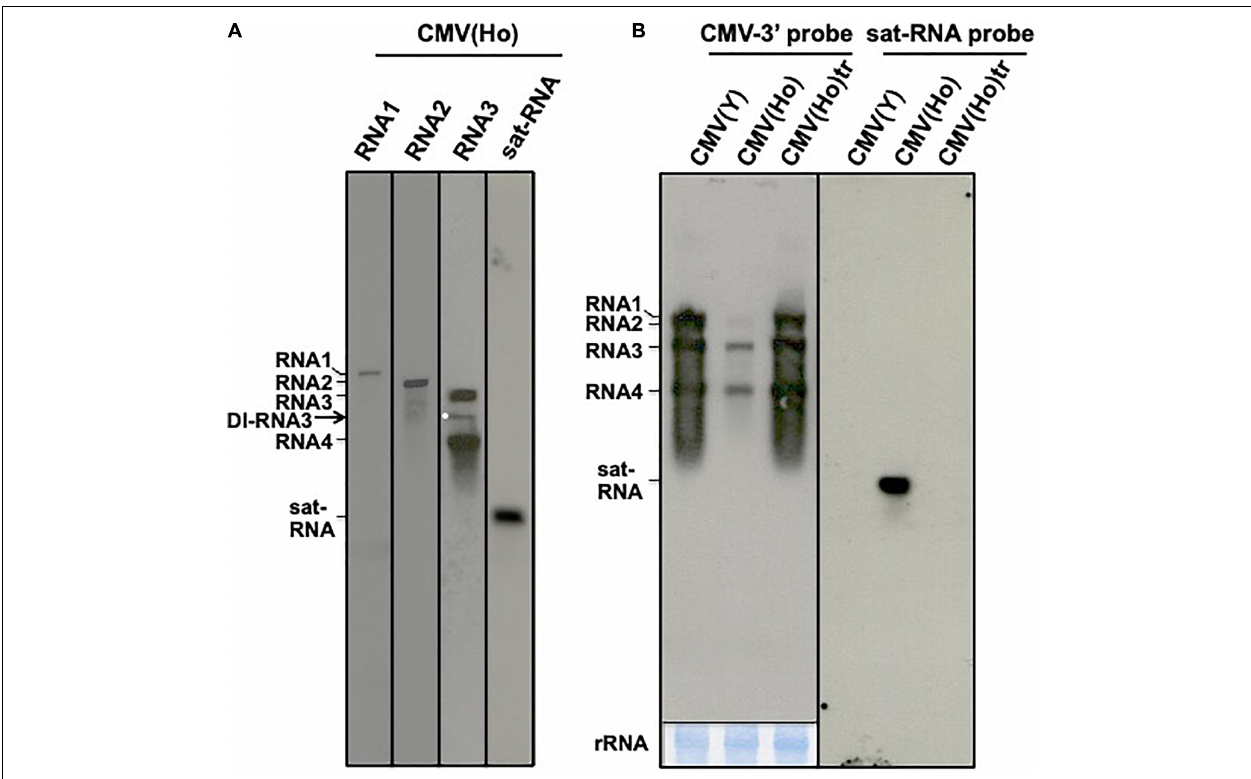
FIGURE 2 | Northern hybridization analysis of CMV(Ho) RNAs. CMV(Ho) RNA, which was isolated from purified virion, was analyzed by northern hybridization using DIG-labeled probes specific to CMV RNA1, RNA2, RNA3, and satellite RNA (sat-RNA), respectively (A) . A white dot indicates a band of defective interfering (DI)-RNA3. Total RNA, which was isolated from CMV(Ho), CMV(Ho)tr, or virulent CMV(Y)-inoculated leaves of A. thaliana ecotype Col-0, was analyzed by northern hybridization using DIG-labeled probe (CMV-3 (cid:48) probe) binding to 3 (cid:48) -conserved regions of CMV RNA1, RNA2, and RNA3 and DIG-labeled probe (sat-RNA probe) binding to CMV satellite RNA, respectively (B) . As an internal control, rRNA on the blotting membrane is shown at the lower panel by methylene blue staining. After hybridization followed by washing and incubation with CDP-Star substrate, the membrane was exposed for 1 min.